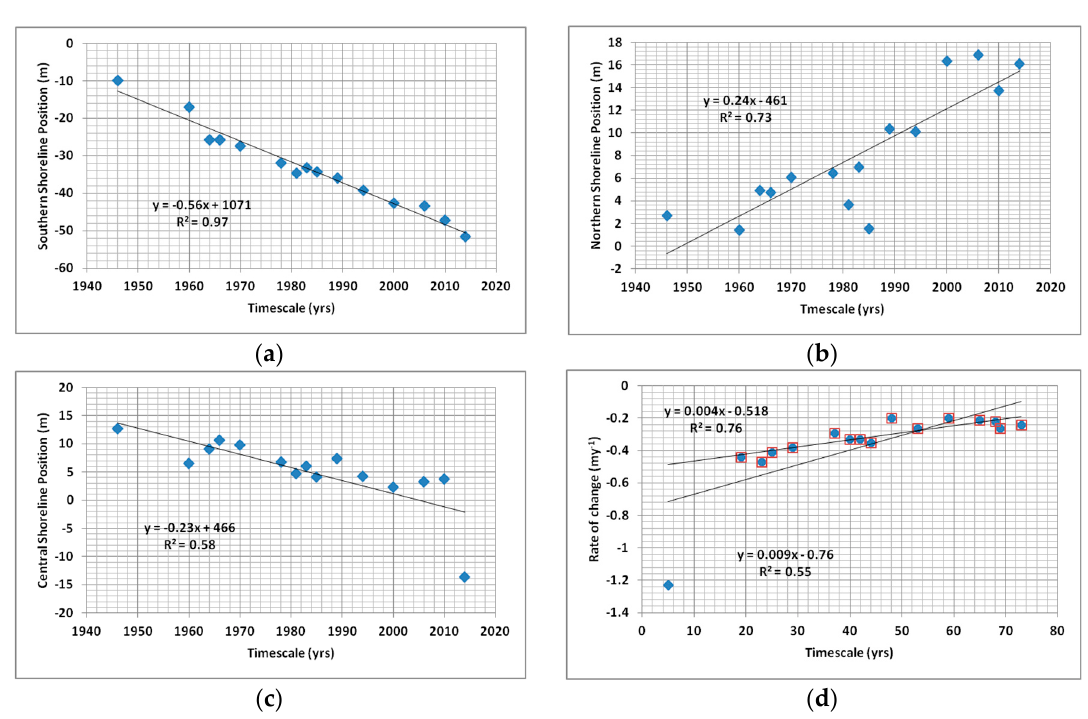
Figure 6. Temporal shoreline positional change between 1941 and 2014, ( a ) southern beach extremity (average T1–T4); ( b ) northern beach extremity (average T8–T12); ( c ) central beach region (average T5–T7) and ( d ) cumulative shoreline rates of change.